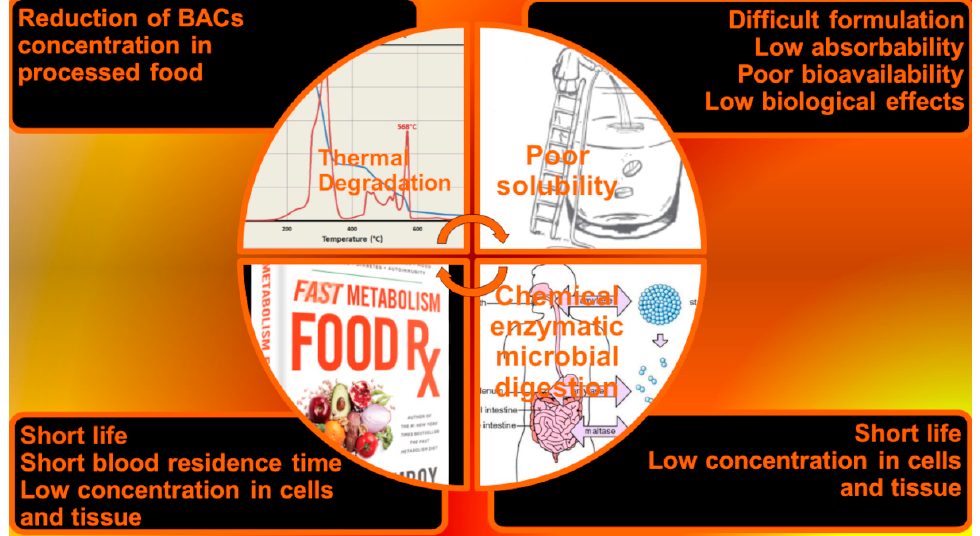
Figure 1. Main criticisms and events that limit the beneficial effects of BACs after oral administration.